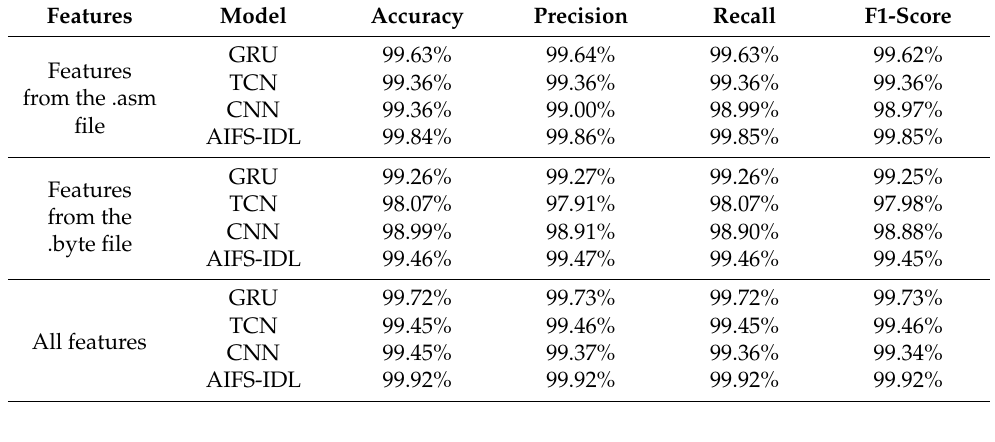
Table 5. Multi-feature fusion experiment results.